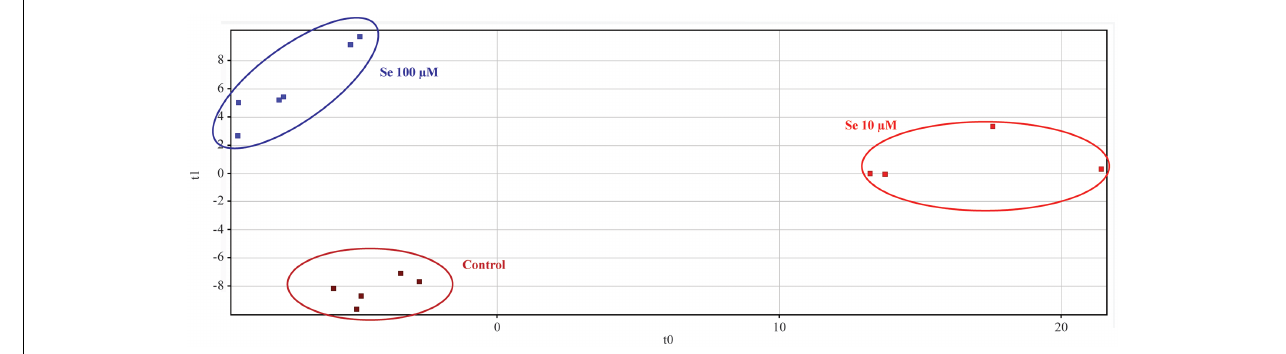
FIGURE 3 | Partial Least Squares Discriminant Analysis (PLS-DA) carried out on strawberry fruit samples produced by plants grown in a full nutrient (control) and a nutrient solution either supplied with 10 or 100 µ M